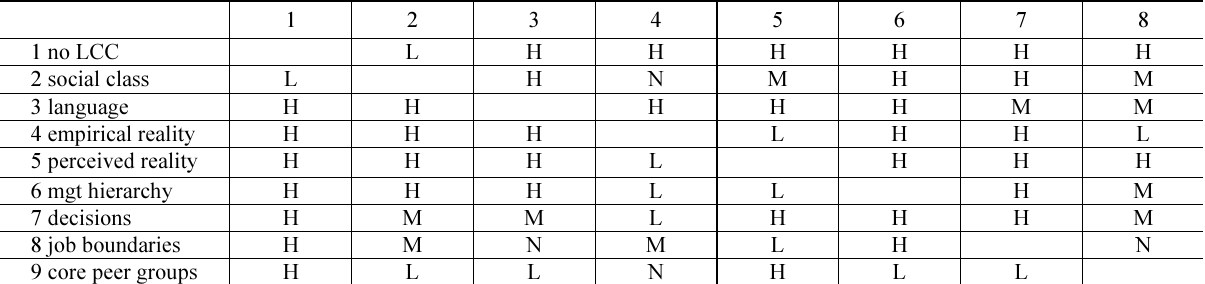
Table 1. Strength of relationship between researched variables (H – high; M – medium; L – low; N – no effect) 1